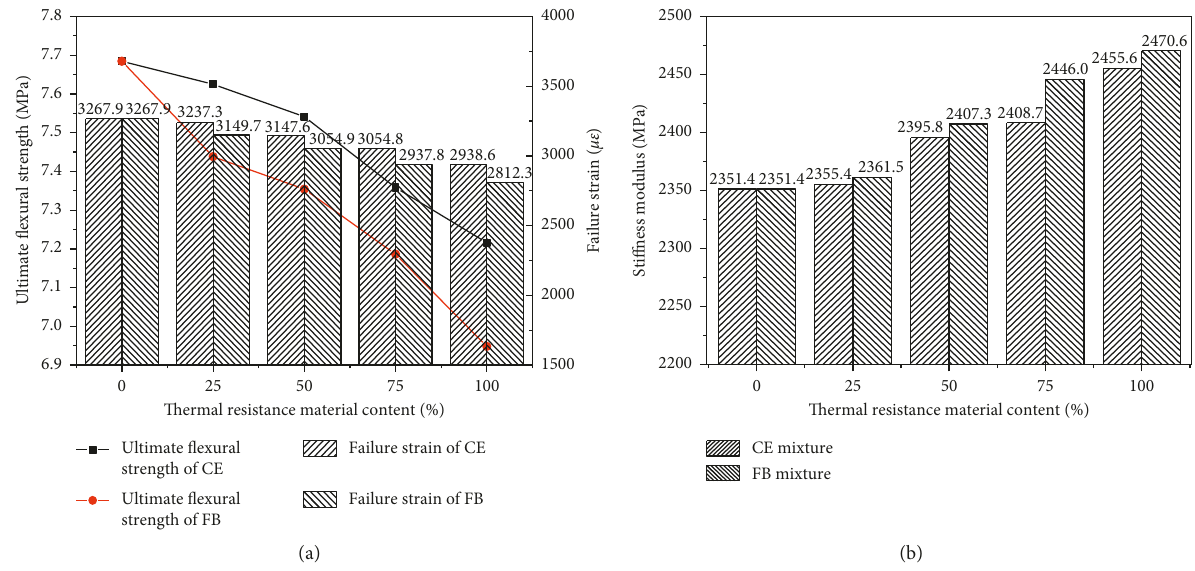
Figure 9: Results of the little beam bending test. (a) Ultimate flexural strength and failure strain and (b) stiffness modulus.